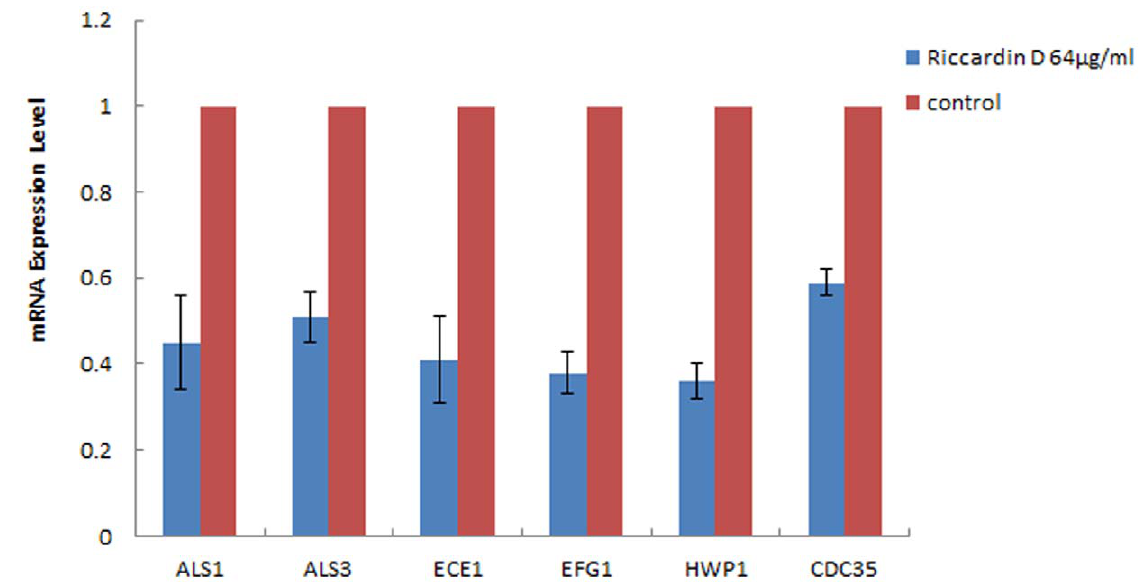
Figure 6. Expression of C.albicans biofilms-related genes. Different expression of genes ALS1, ALS3, ECE1, EFG1, HWP1 and CDC35 following the treatment with riccardin D (64 m g/ml) for 18 h. The biofilms grew for 48 h totally. ACT1 works as an internal control.